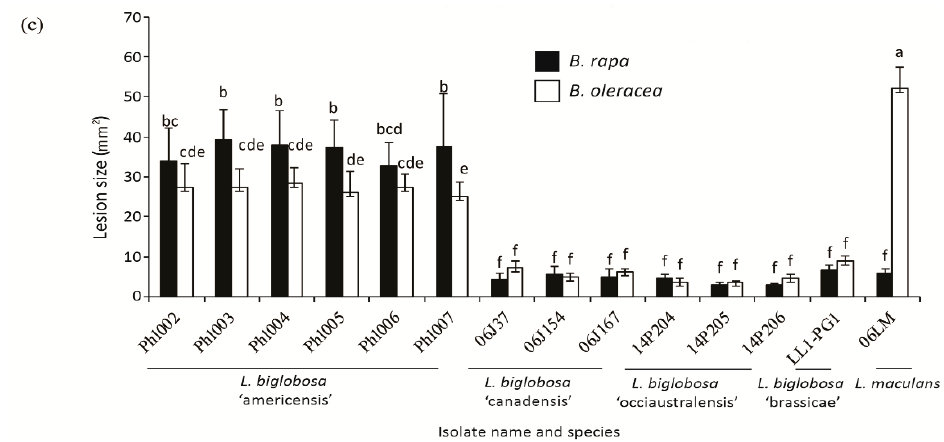
Figure 5. Pathogenicity assessment of 14 Leptosphaeria isolates belonging to four subclades of L. biglobosa and one isolate of L. maculans as a control treatment: L. biglobosa ‘americensis’ isolates (Phl002 to Phl007); L. biglobosa ‘canadensis’ isolates (06J37, 06J154, 06J167); L. biglobosa ‘occiaustralensis’ isolates (14P207, 14P205, 14P206); L. biglobosa ‘brassicae’ isolate (LL1-PG1); and L. maculans isolate (06LM). Each isolate was inoculated onto seedlings of each of two Brassica napus cvs, Westar and Jet Neuf ( a ); two B. juncea cvs., Forge and common brown mustard (CBM) ( b ); B. rapa turnip cv., Mizspoona, from the Willamette Valley of Oregon; and B. oleracea cabbage cv., Copenhagen Market ( c ). The lesion sizes were quantified 14 days’ post-inoculation (dpi) using Assess 2.0 (American Phytopathological Society, St Paul, MN) for each test, isolate, and Brassica cultivar as described in the main text, and statistical analyses performed using SAS Version 9.4 (SAS Institute, Inc., Cary, NC) for analysis of variance (ANOVA) and means comparison with Tukey’s Honestly Significant Difference Studentized range test at p ≤ 0.05. Each bar represents the mean and standard deviation of the lesion size for a particular Brassica species. Different letters (from ‘a’ to ‘f’) over the bars indicate the significant differences ( p <